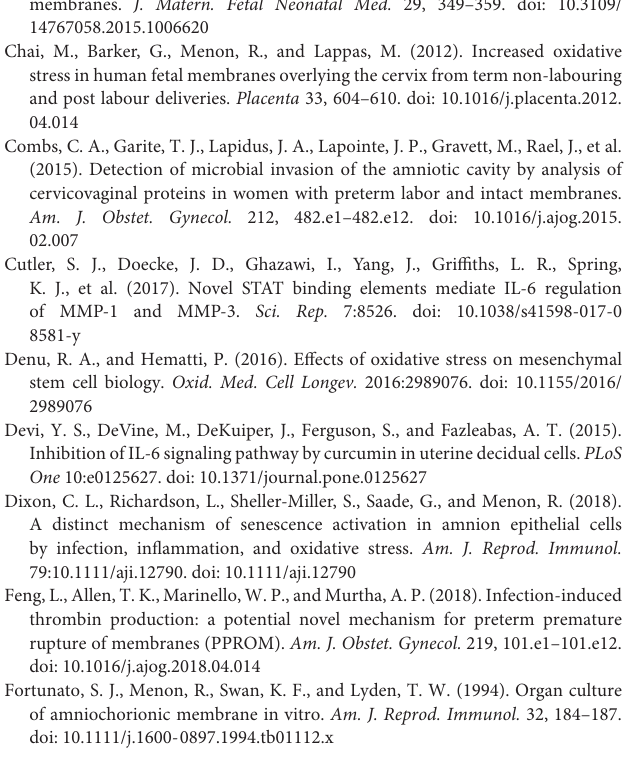
FIGURE S1 | IL-6 induced dose-dependent STAT3 activation in primary decidua cells validating its functionality. (A) Decidual cells were treated with IL-6, with doses as reported in the literature that can cause STAT3 activation, to validate the recombinant and commercially available IL-6 used for the treatments in our study. Western blot analysis showed that IL-6 treatment increased the activation of the downstream transcription factor STAT3 at pathologic levels compared to control (2.7-fold). N = 3; mean ± SEM. FIGURE S2 | IL-6 does not induce cell cycle changes in AECs. Cell cycle analysis was performed by measuring the DNA content and used to distinguish between different phases of the cell cycle after a physiologic or pathologic dose of IL-6. Fluorescence intensity that directly correlated with the amount of DNA contained in a cell was measured by flow cytometry. Concurrent parameter measurements made it possible to discriminate between S (red), G2 (blue), and mitotic cells (SubG0 in purple and G0 in pink). (A) Physiologic doses of IL-6 mimicking early gestation (330 pg/mL), mid-gestation (1,650 pg/mL), and term labor (3,300 pg/mL) do not affect normal cell cycle progression at sub G0, G0, S phase, or G2. Fluorescence intensity units (FIU). N = 3; mean ± SEM. (B) Pathologic doses of IL-6 seen in the amniotic fluid of infectious pPROM do not affect normal cell cycle progression at sub G0, G0, S phase, or G2 when compared to control or term labor treatments. Fluorescence intensity units (FIU). N = 3; mean ±